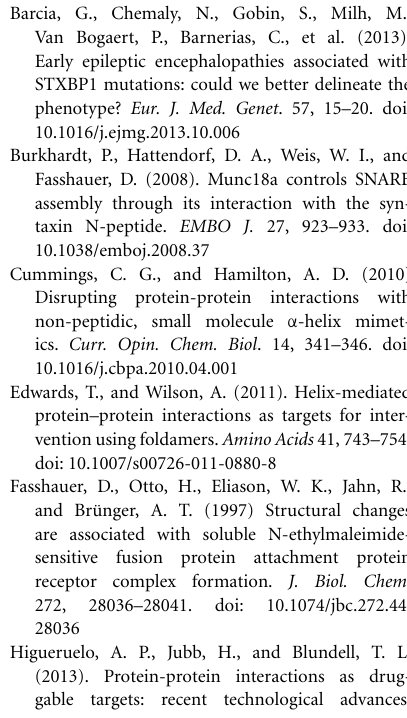
functional SNARE fusion complex assembly, and SNAP25 only becomes re-involved in a later step of the pathway which is not shown here. In STXBP1 haploinsufficiency, the number of functional STXBP1 molecules is reduced, resulting in less efficient disassembly of non-productive SNARE complexes and thus reducing the number of STXBP1:syntaxin1a heterodimers present. The less efficient production of this starting point, which may represent a rate-limiting step of the pathway due to the general stability of SNARE complexes, results in an impairment of eventual neurotransmitter release (not shown here). However, increasing the number of readily-available syntaxin1a monomers, with the use of a syntaxin1a:syntaxin1a PPI inhibitor, may restore the balance of the STXBP1:syntaxin1a starting point formation of fusion complex assembly in STXBP1